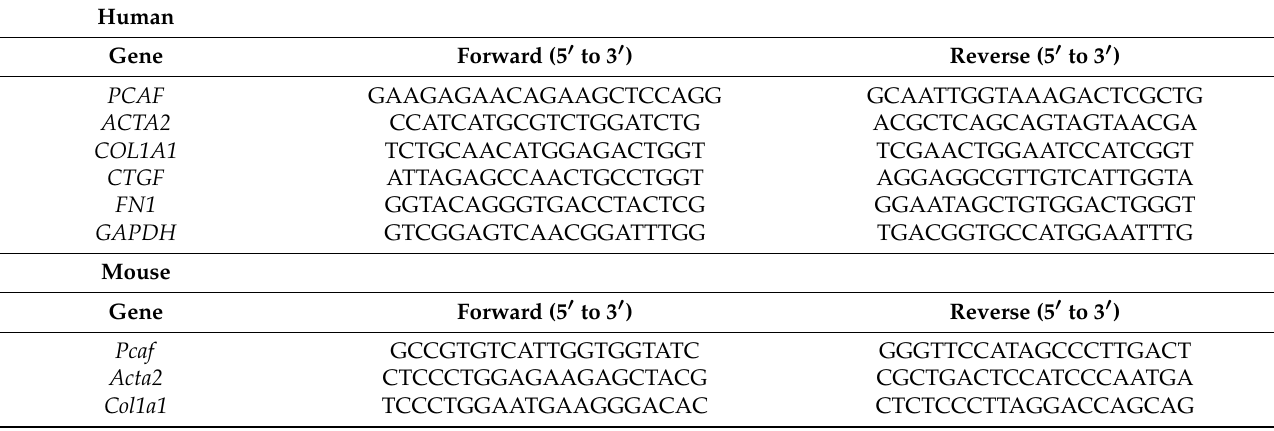
Table 1. Real-time PCR primer sequences used in this